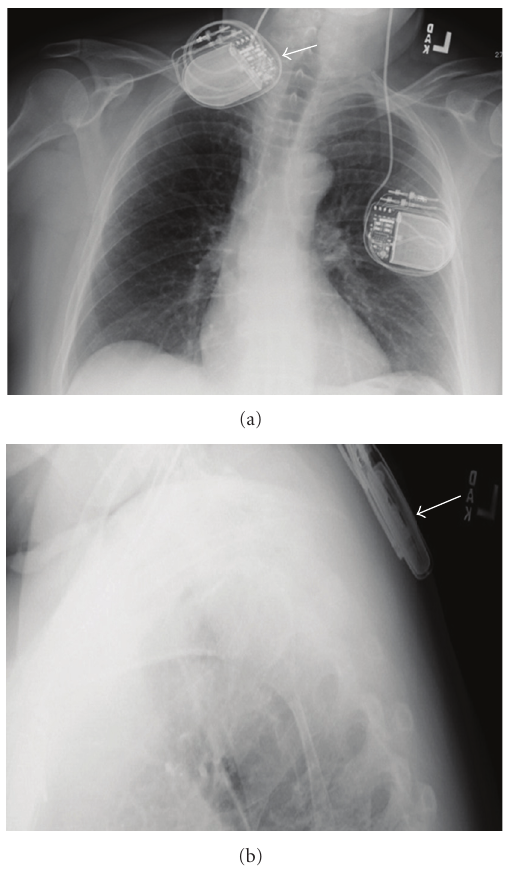
Figure 6: Postoperative X-ray showing placement of the right IPG in suprascapular region after the last